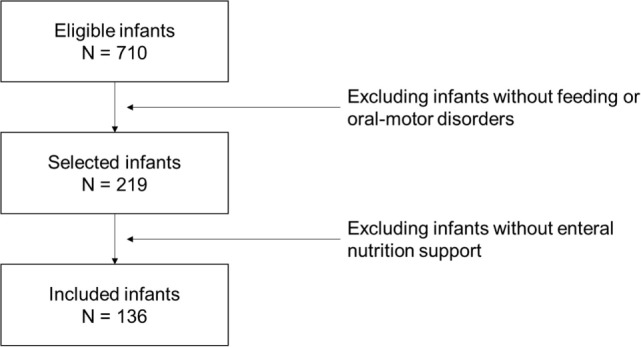
Sample flow chart.